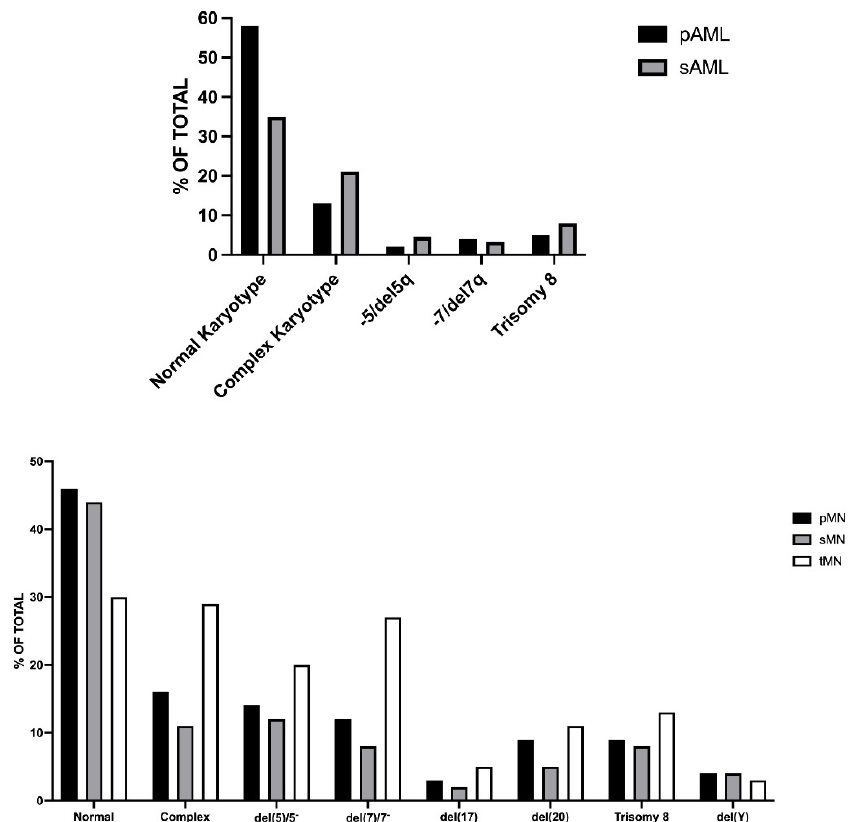
Figure 2. Cytogenetic abnormalities in pAML, sAML and tAML. Top Panel: main cytogenetic abnormalities observed in pAML and sAML. The Figure is based on the data reported by Nazha et al., 2016 [9]. Bottom Panel: main cytogenetic abnormalities observed in pAML, sAML, and tAML. The Figure is based on the data reported by Kuzmanovic et al. 2016. [11].